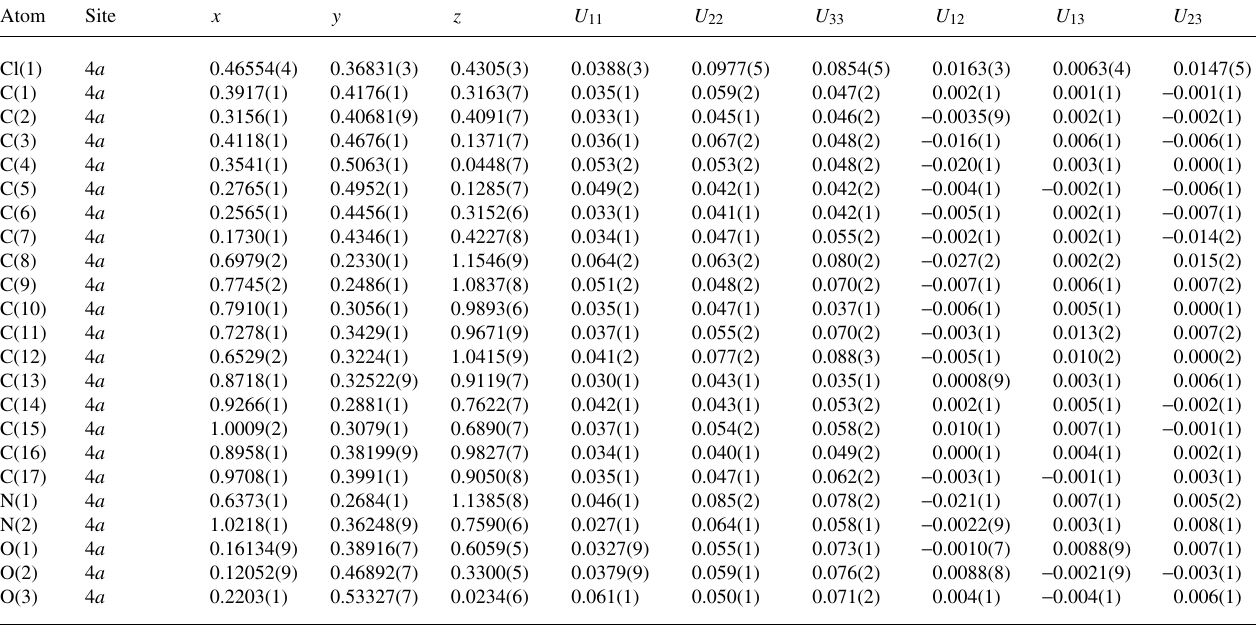
Table 3. Atomic coordinates and displacement parameters (in Å 2 )